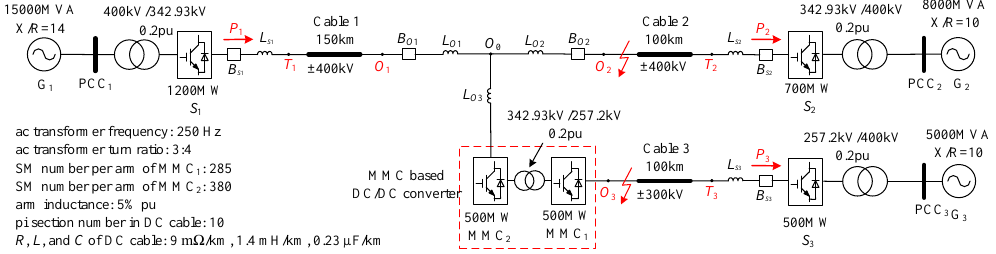
Figure 1. Radial three-terminal high-voltage direct current (HVDC) system using average models of half-bridge (HB)-based modular multilevel converters (MMCs), incorporating a front-to-front DC/DC converter based on MMCs.